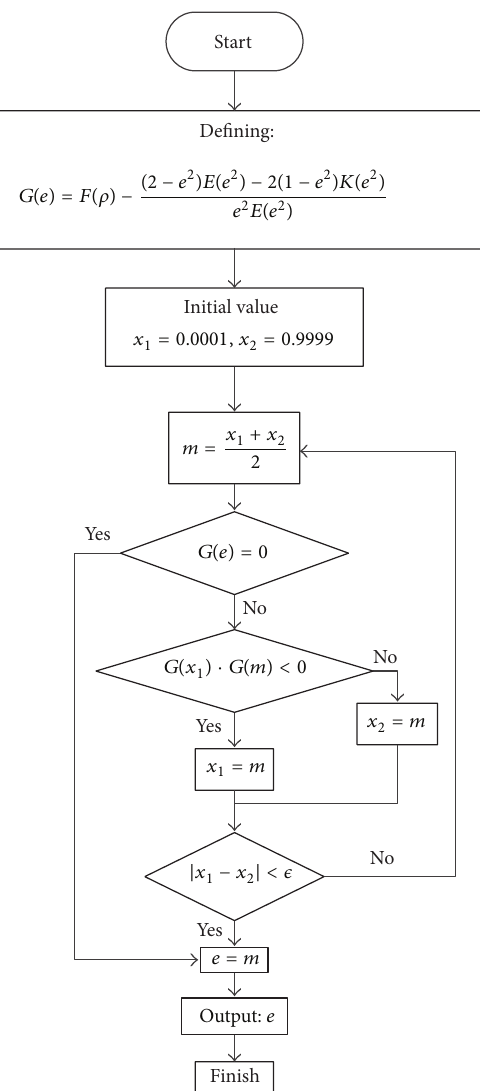
Figure 5: Program chart of